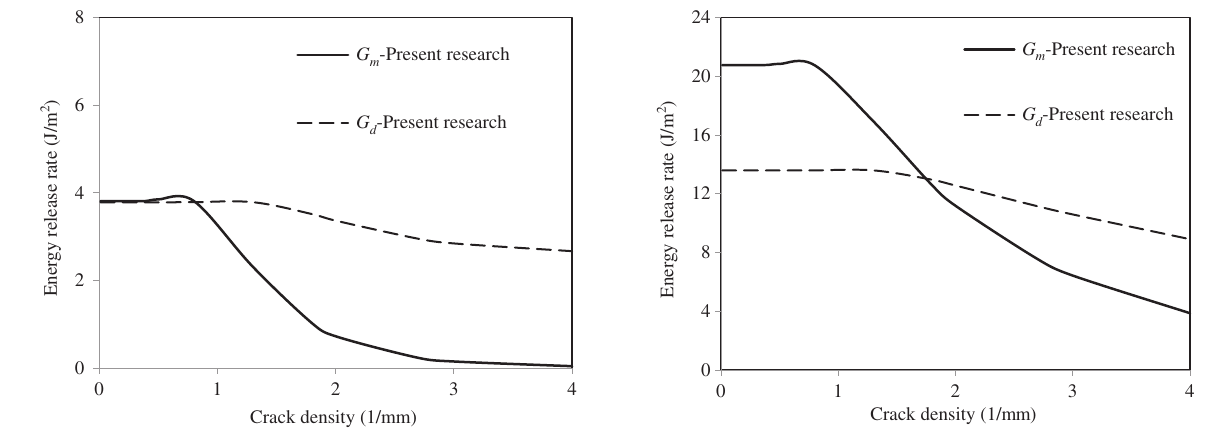
= 100 MPa, σ = 1 MPa and σ = 10 MPa. 1 12 2